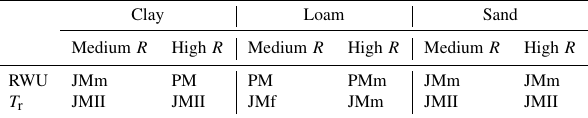
Figure 13. Box plot of the coefficient of determination r 2 and model efficiency coefficient E for the comparison of root water uptake (RWU) and actual transpiration ( T a ) predicted by empirical models compared to De Jong van Lier et al. (2013) model predic- tions, for the growing season experiment, two levels of root length density, and three soils. The symbols ∗ and ◦ represent the average and outliers, respectively. Table 7. Best models for the evaluated scenarios (root length den- sity R and soil type) based on Akaike’s information criteria AIC through comparison of root water uptake (RWU) and relative tran- spiration ( T r ) predicted by the De Jong van Lier et al. (2013) physi- cal model in the growing season